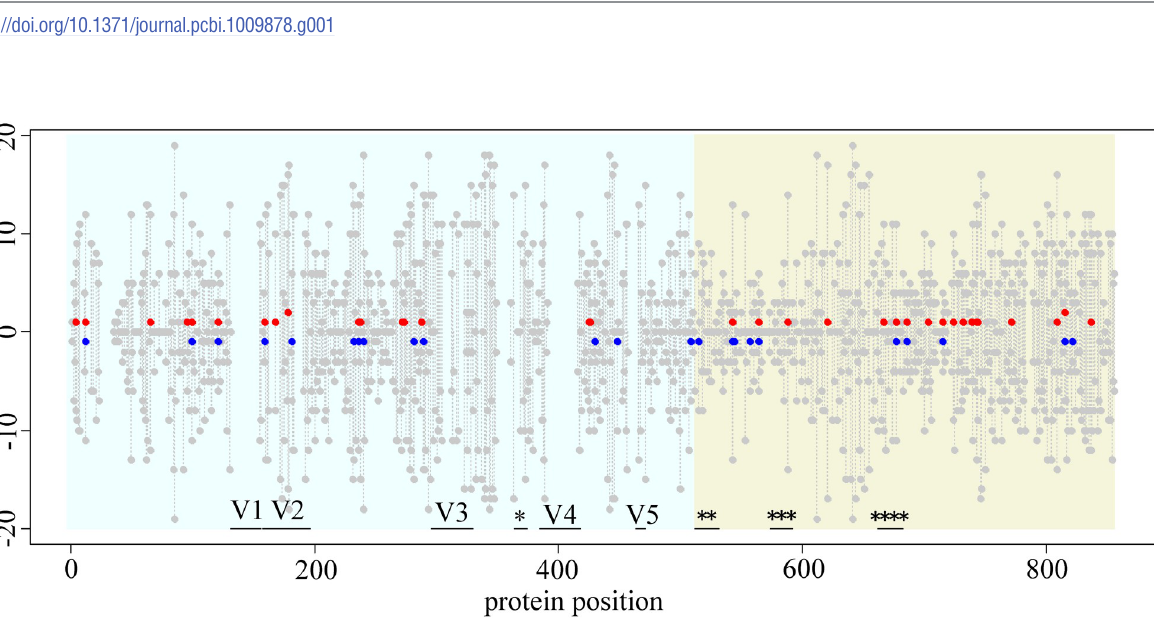
Fig 1. Schematic representation of the approach for inference of changes in fitness of individual amino acids. Both A and B are variable fitness amino acids when species 1 and 2 are chosen as focal nodes, because each of them is proximal to one species and distal from the other. By contrast, A is distal, and B is proximal, for both species in the comparison of species 2 and 3, so neither A nor B is identified as a variable fitness amino acid in this comparison.